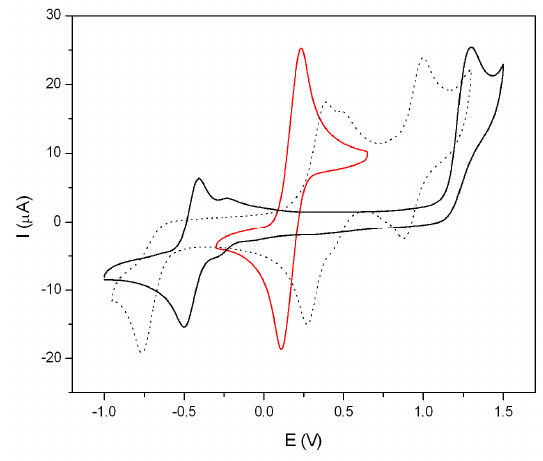
Figure 4. Cyclic voltammograms of 3 (black line) and 5 (dotted line), recorded in CH 2 Cl 2 containing 0.1 M n -Bu 4 N + PF 6 − at a vitreous carbon working electrode at 293 K, v = 100 mV·s − 1 , reference electrode Ag/Ag + , internal reference ferricenium/ferrocene redox couple (red line).